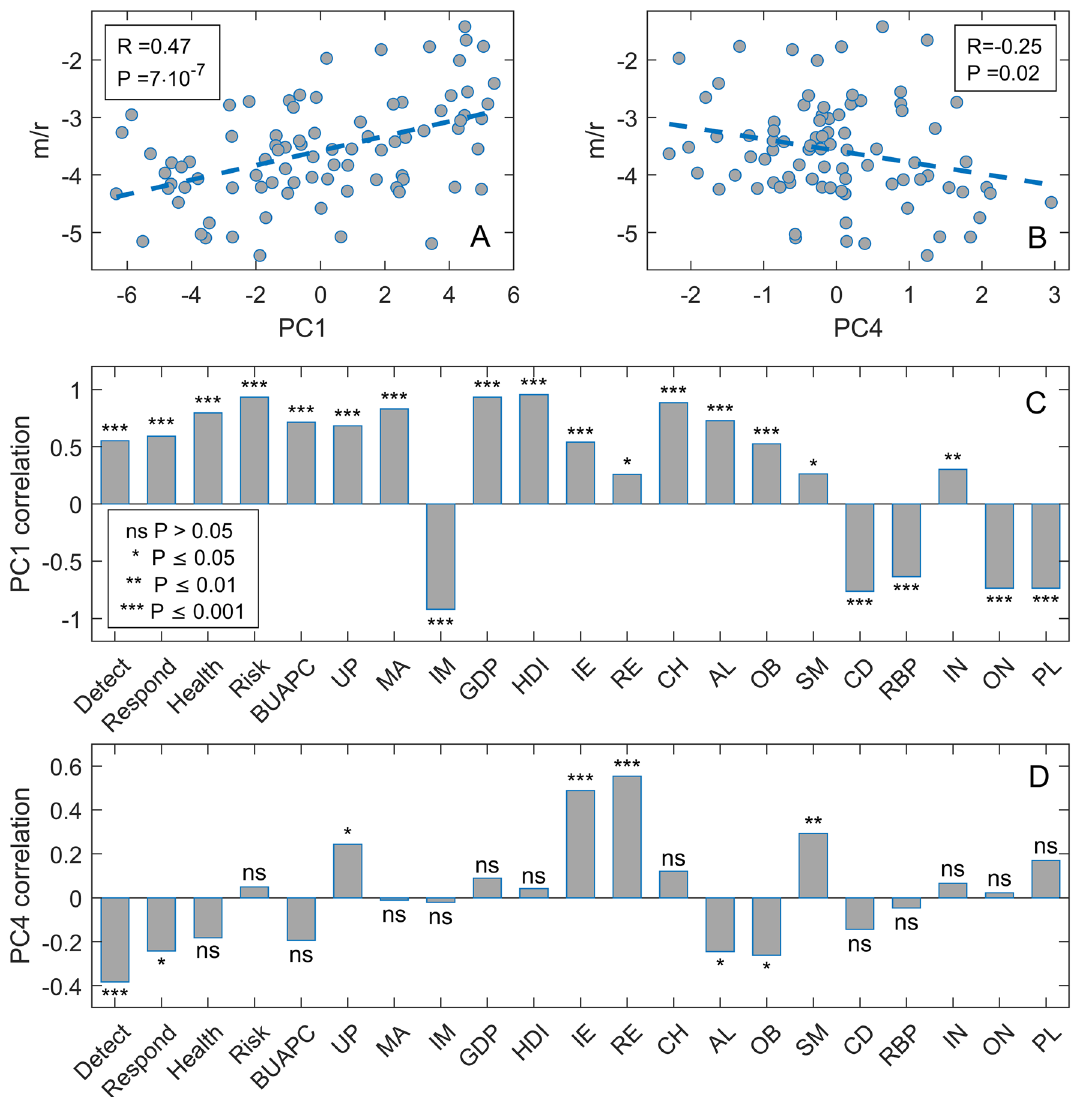
Figure 3. Supervised Principal Component Analysis. Scatterplot of ( A ) PC1 and m/r, ( B ) PC4 and m/r, ( C ) PC1 and variables entering PCA, ( D ) PC4, and variables entering PCA. m/r – mortality over recovery